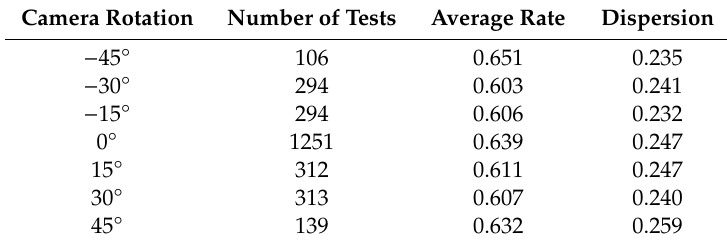
Table A3. Numerical results of the users regarding the camera rotation.